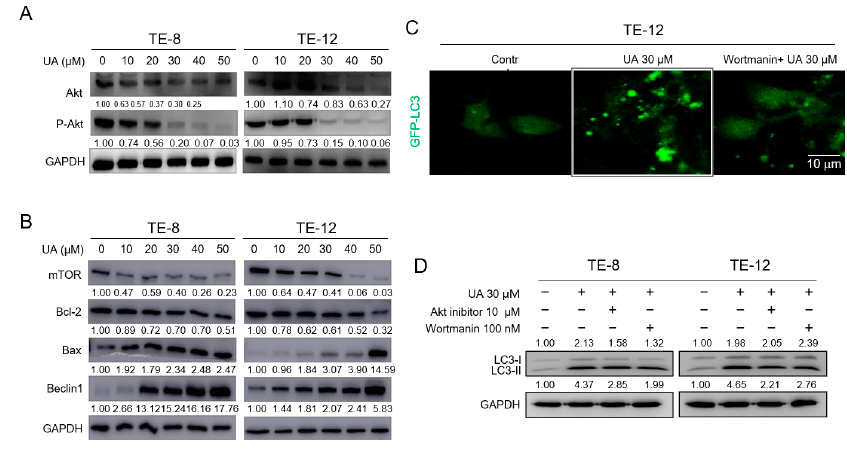
Figure 4. UA induced autophagy in ESCC through the Akt-mTOR signaling pathway. After UA treatment for 48 h, we measured the phosphorylation of Akt ( A ), mTOR, Bcl-2, Bax, and Beclin-1 ( B ) by Western blot analysis. ( C ) We obtained the representative images through confocal